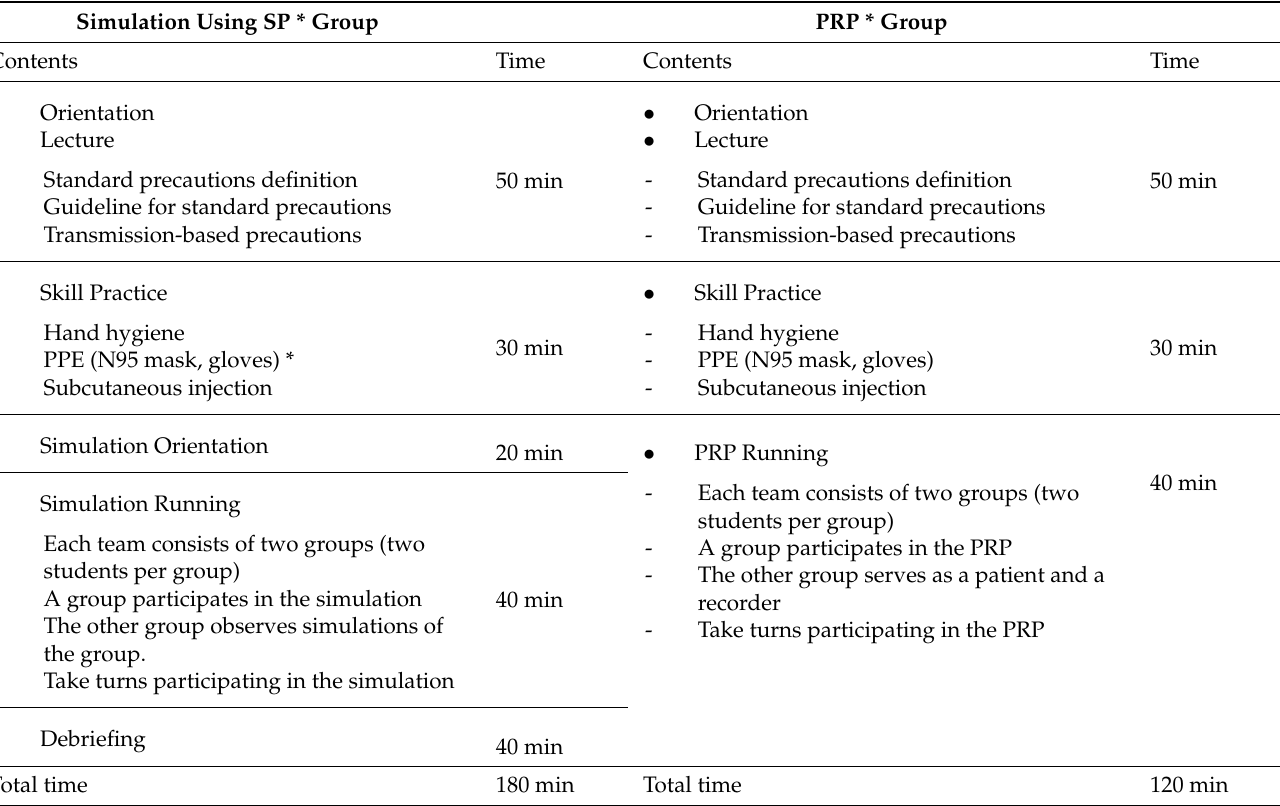
Table 1. Education program